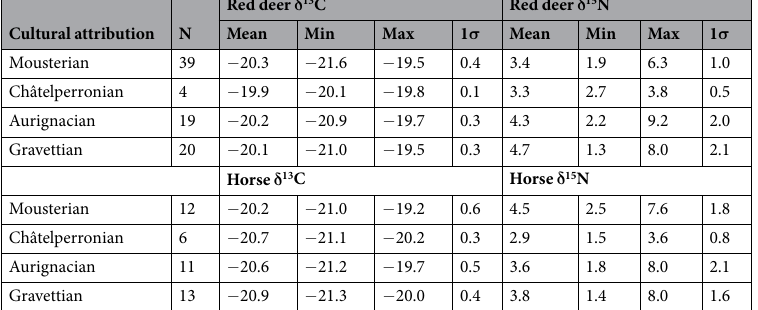
Table 5. Summary statistics for red deer and horse specimens for each cultural period